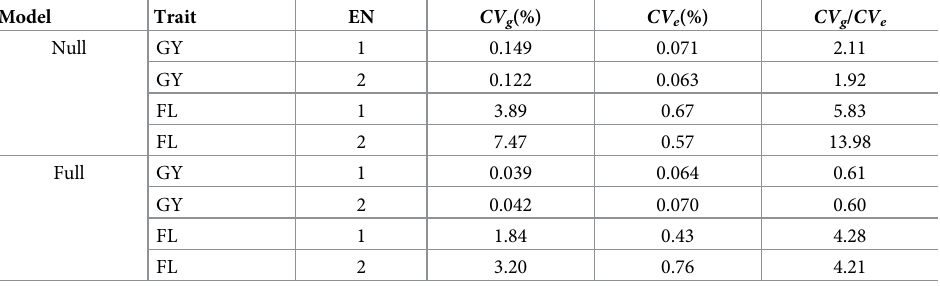
Table 5. Coefficient of variation residual ( CV e , %), coefficient of variation genotypic ( CV g , %) and relative varia- tion index ( CV / CV ) for the multi-trait and multi-environment g e